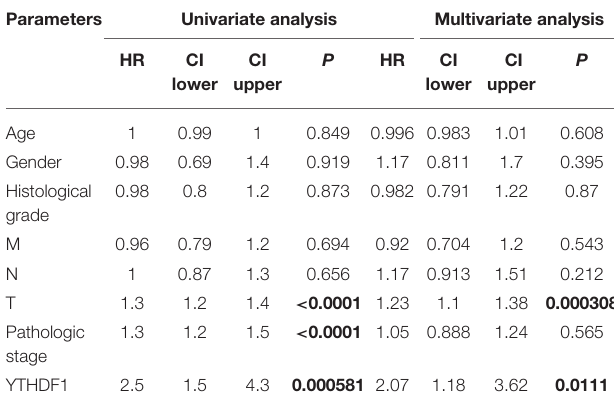
TABLE 2 | Correlation of YTHDF1 expression with clinical features of HCC patients in TCGA. Clinical characteristics